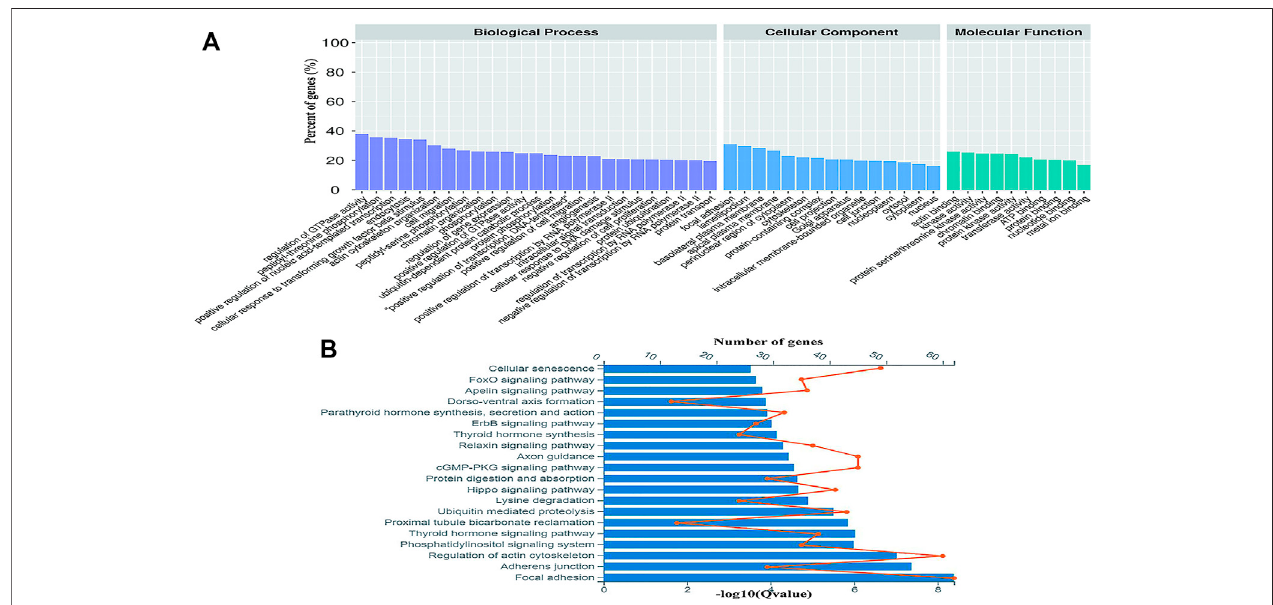
FIGURE 3 | Gene ontology (GO) and Encyclopedia ofGenes and Genomes (KEGG) analyses ofthe parental genesof DE circRNAs. (A) Gene ontology analysis on parental genes of the DE circRNAs. The vertical axis shows the annotated functions of the target genes. The horizontal axis shows the number of genes in each cluster. (B) Kyoto Encyclopedia of Genes and Genomes analysis of parental genes of the DE circRNAs. The orange node represents the number of the DE circRNAs in each pathway and the value of the blue bars shows the -log10 (Q value).